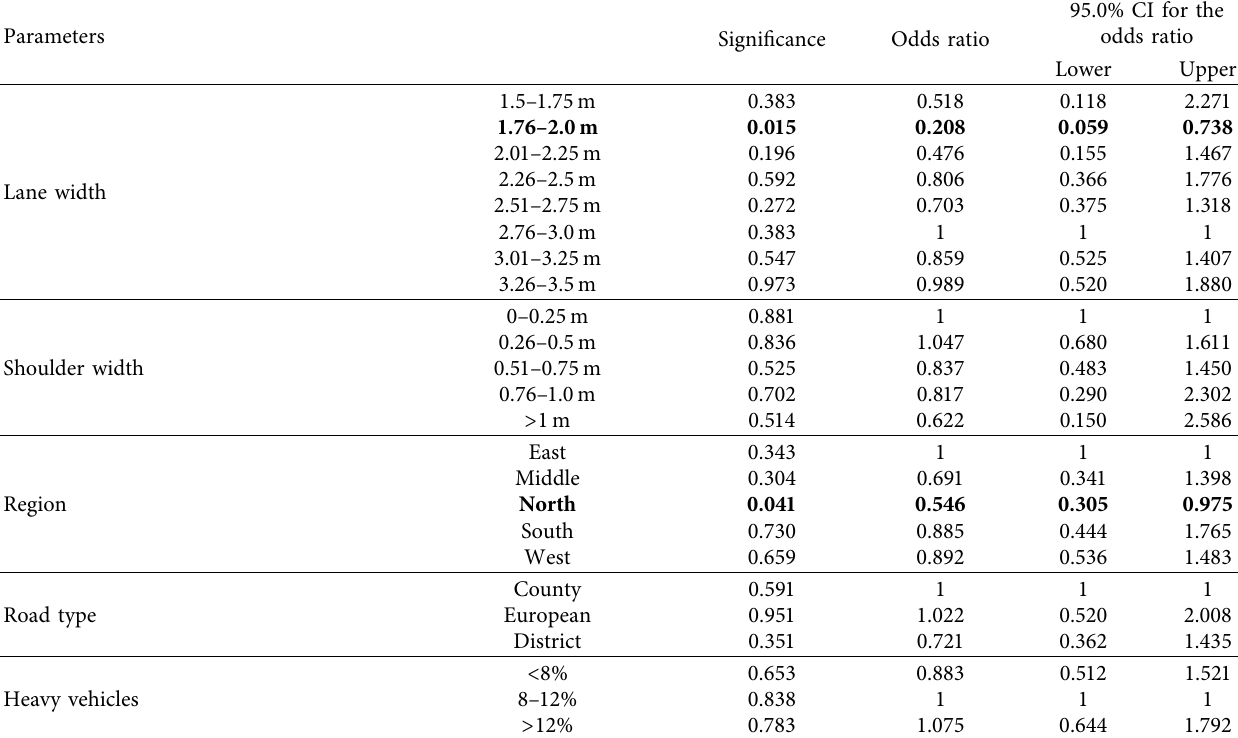
Table 5: Results of the statistical analysis. Significant ( p < 0 . 05 ) results presented in bold